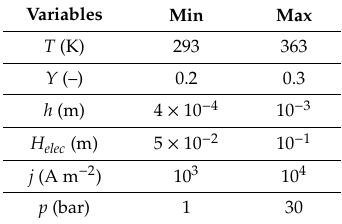
Table 3. Minimum and maximum of the explored parameters for the sensitivity analysis.